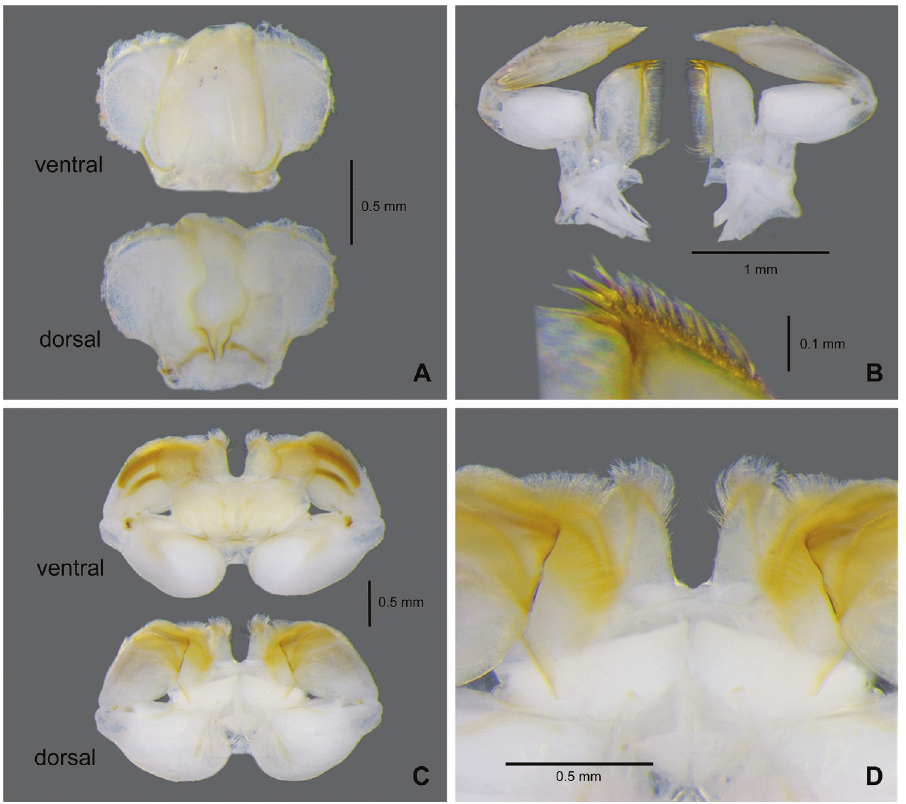
Figure 3. Paegniodes sapanensis sp. nov., larval morphology A hypopharynx B maxilla C labium (ventral view and dorsal view) D enlargement of labium (dorsal